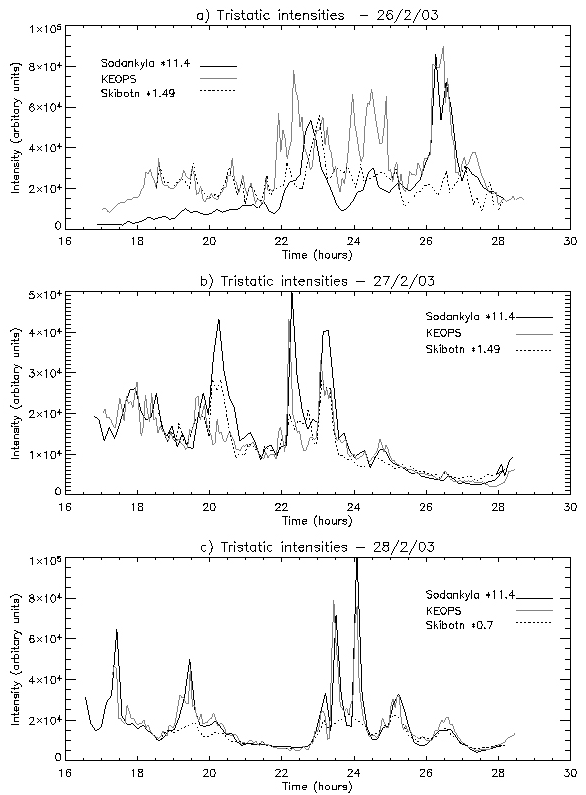
Fig. 13. Comparison of intensities from the 3 FPIs on 3 consecutive nights: (a) 26–27 February 2003, (b) 27–28 February 2003 and (c) 28 February–1 March 2003.